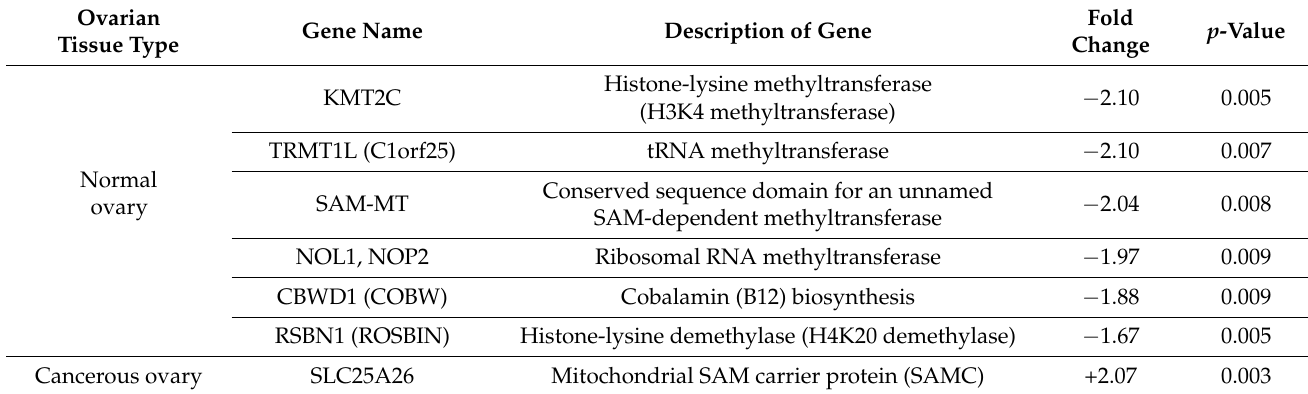
Table 2. Microarray features related to SAM-dependent metabolism, p < 0.01 (WFX10 versus CTL).